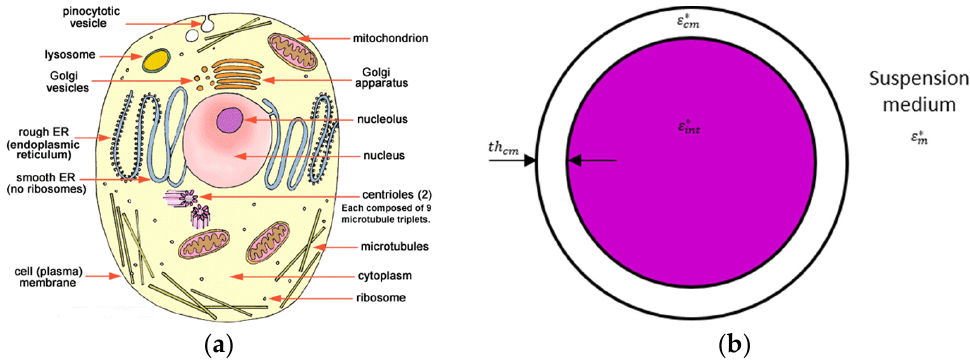
Figure 2. ( a ) Representation of a biological cell in a suspension medium; ( b ) its single-shell model with ε int* the complex permittivity of the cellular content, ε cm* the complex permittivity of the cell membrane and th cm the thickness of the cell membrane and ε ∗ m the complex permittivity of the suspension medium.